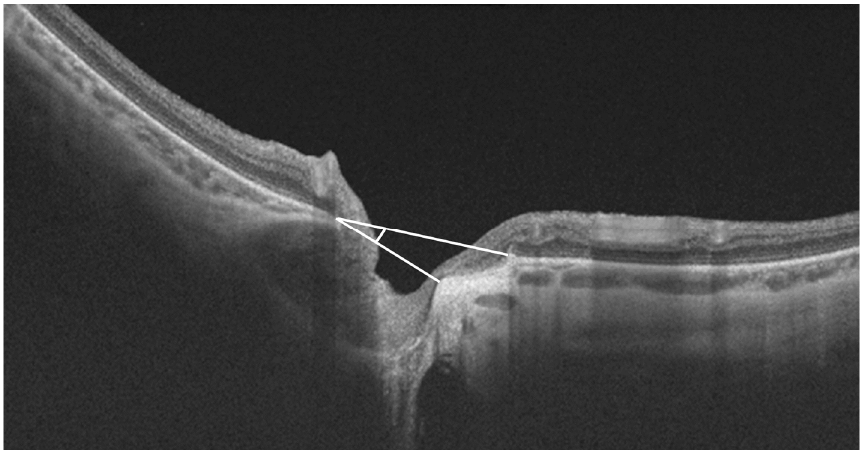
Figure 2. Optic nerve head tilt angle measurement in myopic subject. The tilt angle represents the angle is between the upper white line connecting the inner edges of Bruch’s membrane on each side of the optic nerve head on the cross-sectional optical coherence tomography (OCT) image, and the lower white line connecting the two points marking the clinical disc margin along the OCT cross-sectional scan.